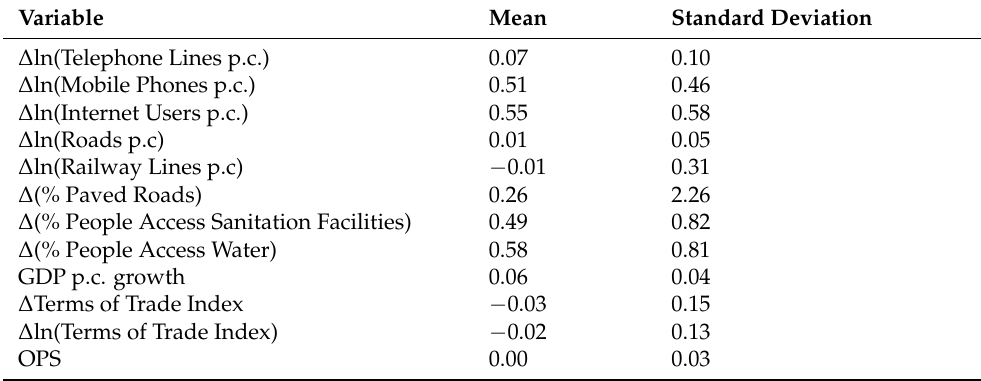
Table 1. Descriptive statistics.